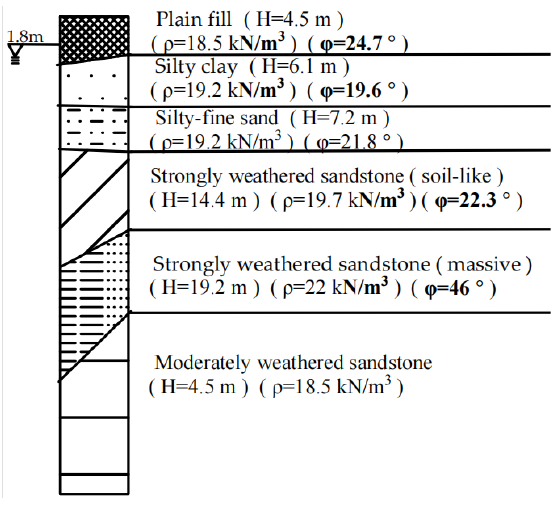
Figure 5. Soil layers and water level in the geological profile.